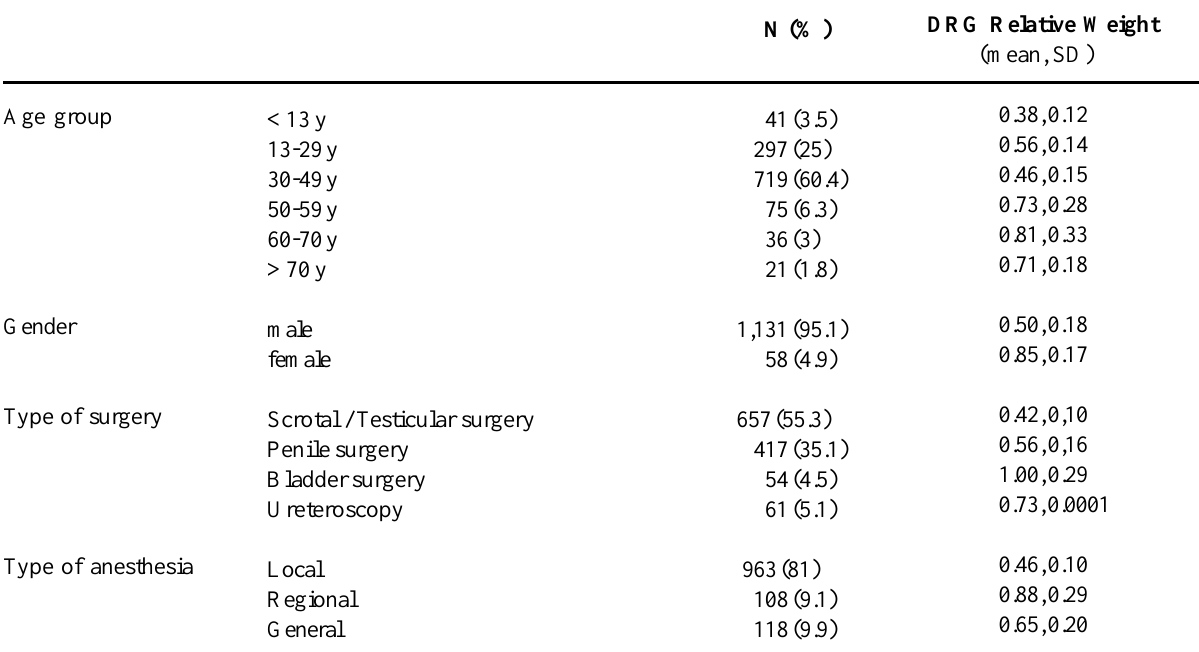
Table 2 – Distribution of age, gender, type of surgery, type of anesthesia and diagnosis-related group (DRG) relative weight for every